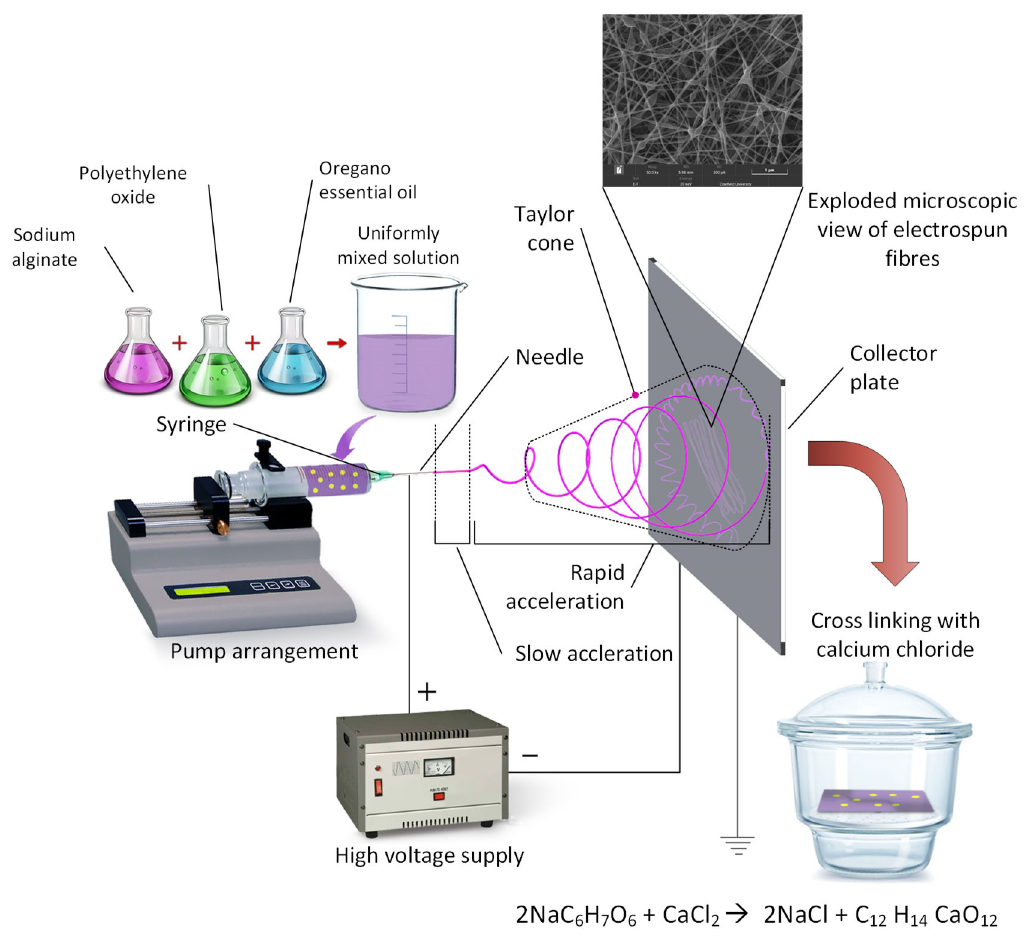
Figure 2. Simple schematic diagram of electrospinning process. The formation of Taylor cones and transition zone can be clearly seen at the tip of the needle (rapid acceleration) and crosslinking process.